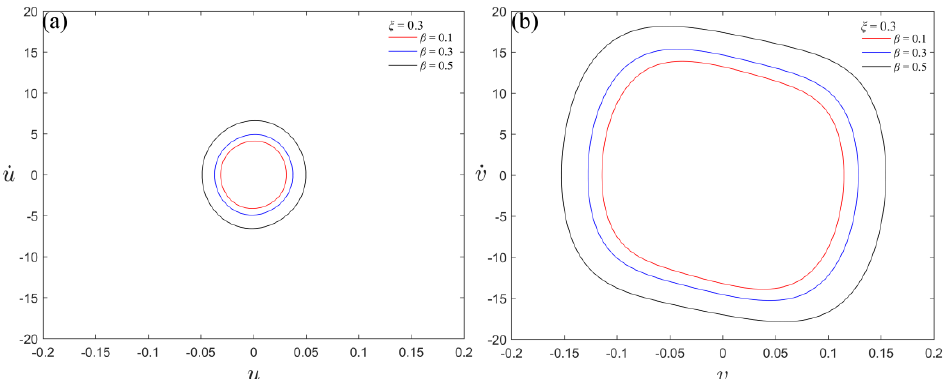
Figure 4. Comparison of phase diagrams between beam without NES and NES in the beam–NES system; ( a ) phase diagram of beam without NES at a frequency of 140.5 rad/s, ( b ) phase diagram of NES in the beam–NES system at a frequency of 136 rad/s.